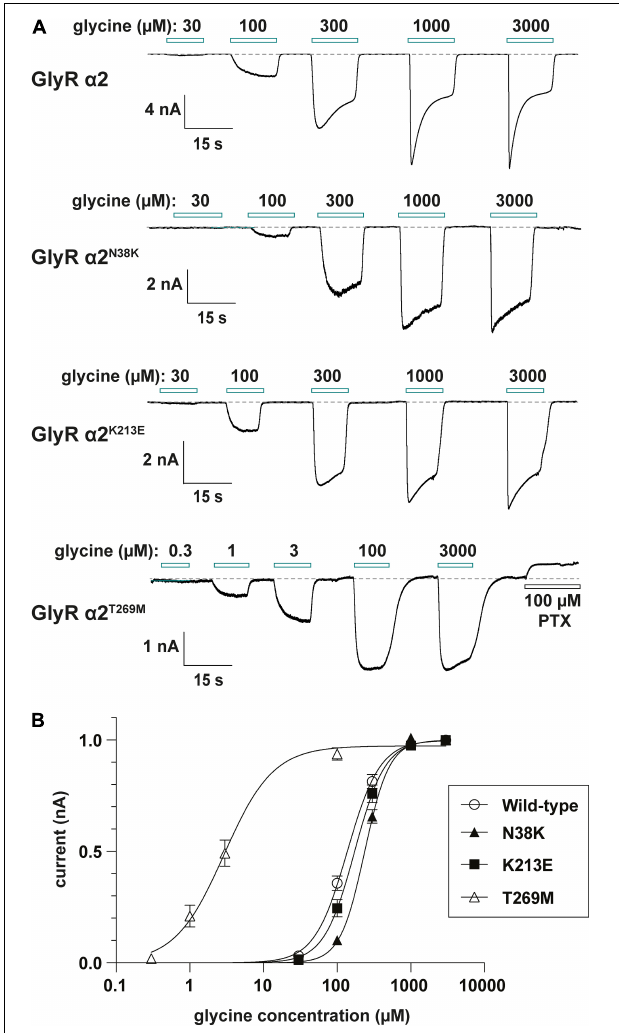
FIGURE 6 | Functional analysis of human GlyR α 2 variants using whole-cell patch-clamp electrophysiology. (A) Glycine dose-response sample traces for wild-type GlyR α 2 and α 2 N38K , α 2 K213E and α 2 T269M variants. Note that the GlyR α 2 V - 22L variant was not studied, since this change is in the signal peptide, and is not located in the mature GlyR α 2 subunit polypeptide. Horizontal bars indicate the applied glycine concentration in micromolar. The effect of applying 100 µ M picrotoxin on baseline current is also shown for the GlyR α 2 T269M variant. Note that this results in an apparent outward current, reflecting a significant leakage current caused by spontaneous GlyR activity. (B) Normalized, averaged glycine dose-response results for wild-type GlyR α 2 and α 2 N38K , α 2 K213E and α 2 T269M variants. Note that GlyR α 2 T269M also exhibits a significantly reduced glycine EC 50 value, which results in GlyR α 2 T269M activation at low micromolar glycine concentrations. Parameters of best fit to the Hill equation are summarized in Table 2 .